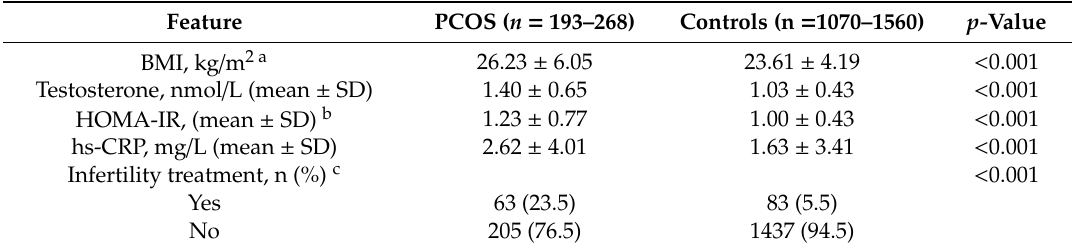
Table 3. Clinical and biochemical features in women with polycystic ovary syndrome (PCOS) and non-PCOS